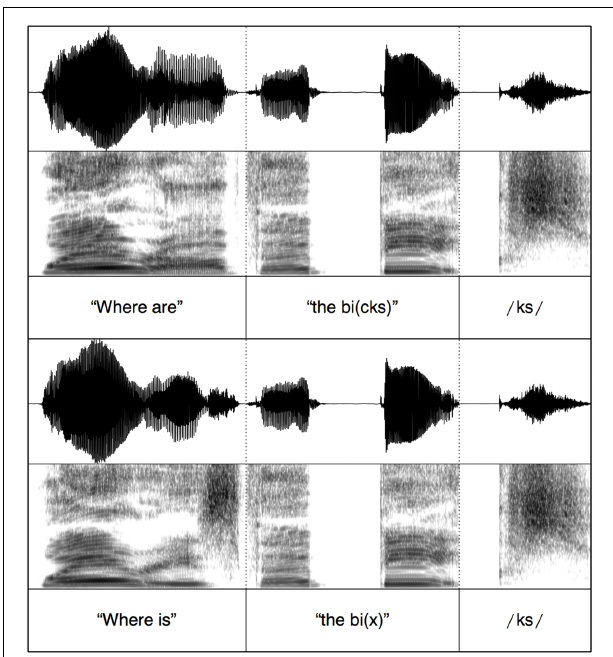
FIGURE 1 | Example stimulus splicing for auditory stimuli with the copula is/are.